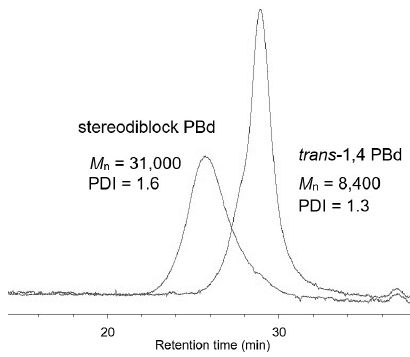
Figure 4. GPC traces of trans ‐ 1,4 prepolymer and stereodiblock polymer synthesized in Run 10.